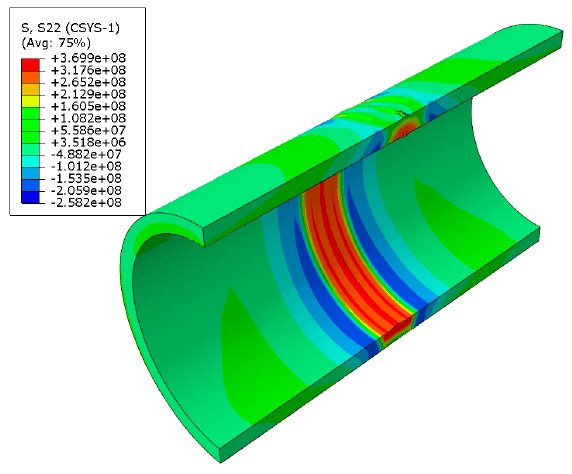
Figure 19. Full-field hoop residual stress distributions.